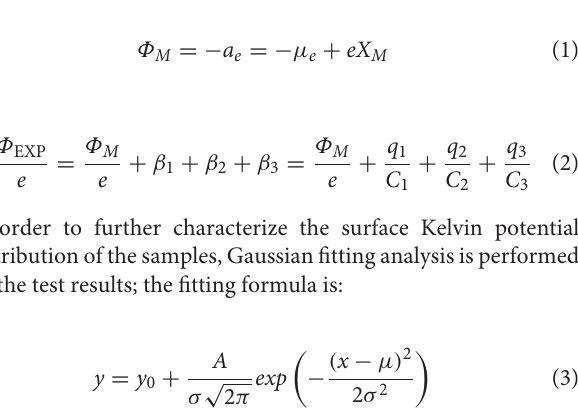
Frontiers in Materials |